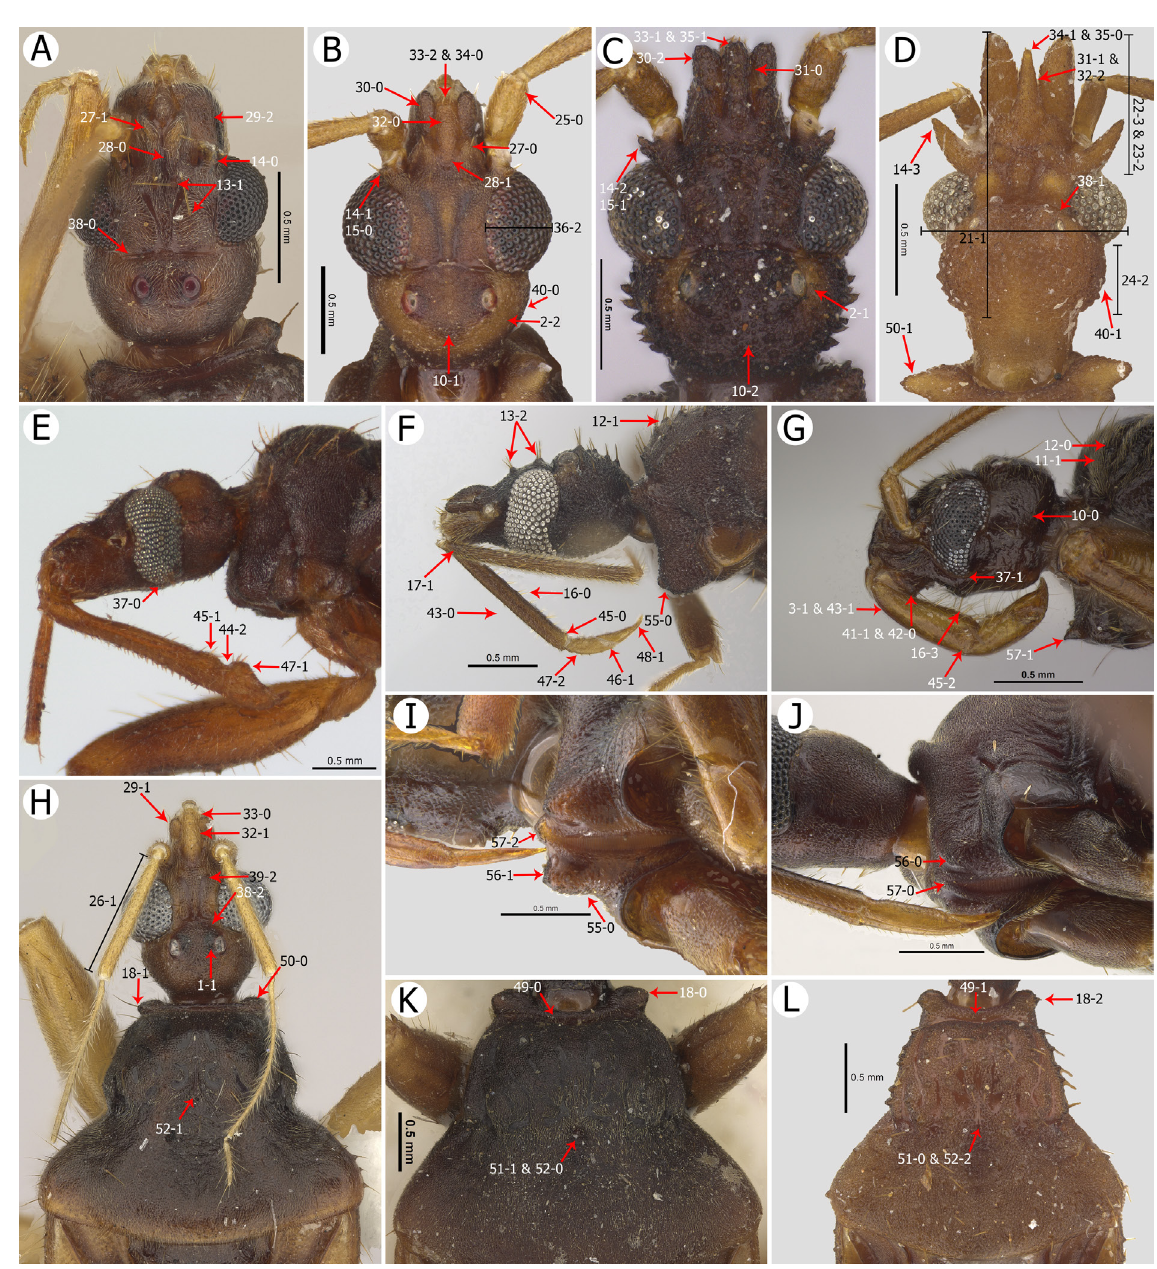
Fig. 3. Morphological characters. A–D . Head in dorsal view. A . Gerbelius nr. confluens . B . Voconia decorata sp. nov. C . Voconia pallidipes Stål, 1866. D . Voconia schoutedeni (Villiers, 1964) comb. nov. E–G . Head in lateral view. E . Voconia wegneri (Miller, 1954) comb. nov. F . Voconia dolichocephala sp. nov. G . Gerbelius typicus Distant, 1903. H . Voconia loki sp. nov., head and pronotum in dorsal view. I–J . Prosternum in ventrolateral view. I . Voconia mexicana sp. nov. J . Voconia bracata sp. nov. K–L . Pronotum in dorsal view. K . Voconia conradti (Jeannel, 1917) comb. nov. L . Voconia tuberculata sp.